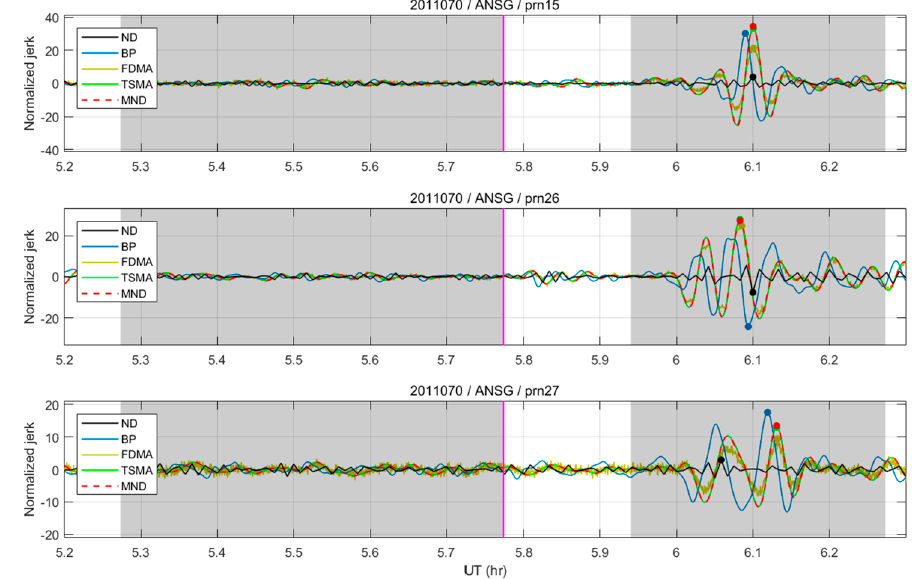
Figure 10. The filtering outputs of conventional (ND and BP) and proposed (FDMA, TSMA and MND) detection algorithms.